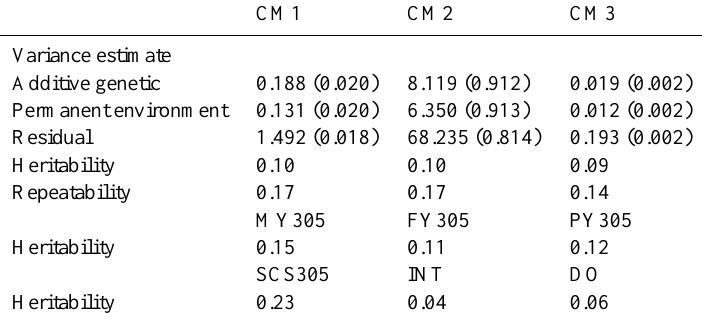
Table 3. Variance components and their standard errors (in parentheses) estimated for the number of clinical mastitis (CM) cases per lactation, the number of days of CM per lactation, and CM considered as an all-or-none trait with values of 0 (no CM case) and 1 (at least 1 CM case).